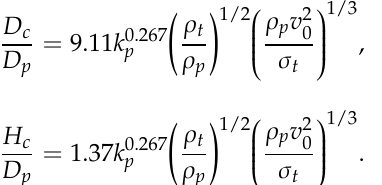
Figure 15. Experimental and predicted crater volumes.